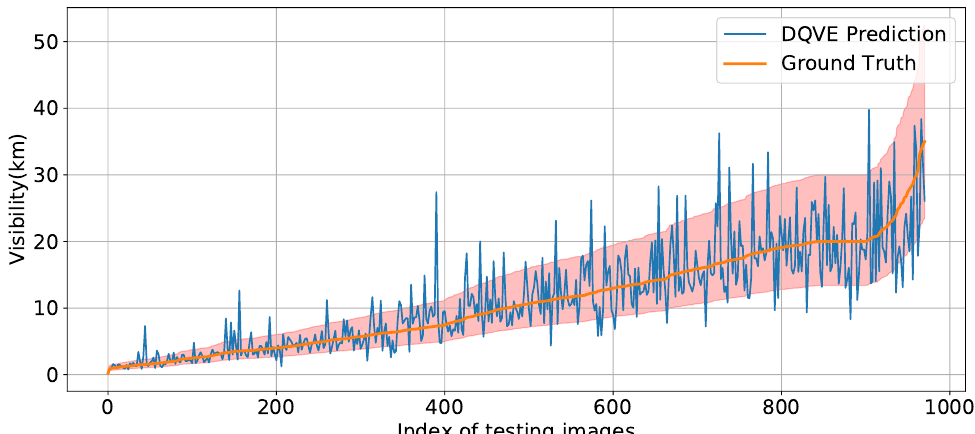
Figure 5. Quantified visibility estimation of DQVENet vs. groundtruth